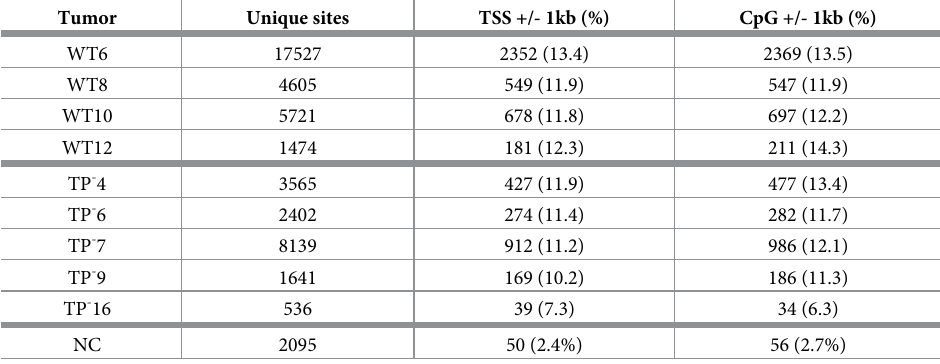
Table 1. MLV integration site mapping of WT MLV and MLV IN TP - tumors from MYC/Runx2 mice.